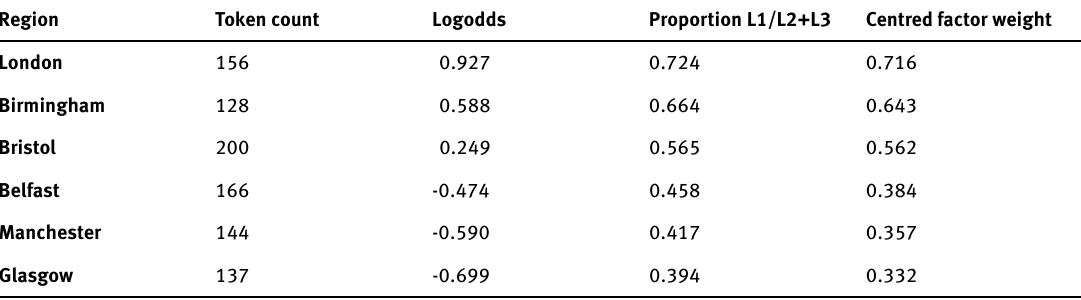
Table 8: Mixed effects variable rule analysis of SMLS (L1) vs. multiple letter forms (L2+L3), interaction with region Region Token